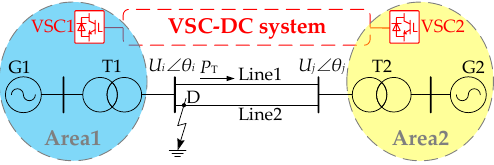
Figure 4. A typical two-area power system, including a VSC-DC